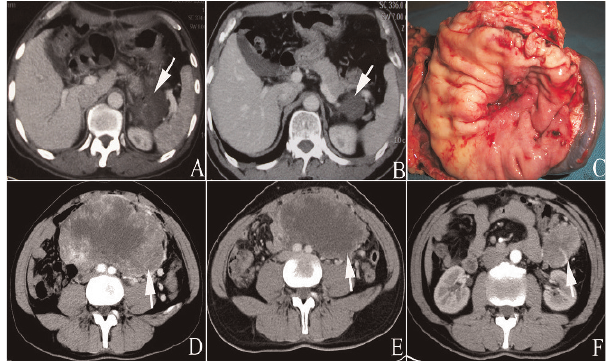
Figure 1 - (Patient no. 1, ABC) The abdominal enhanced CT scan (A) obtained at 3 months after initiation of IM therapy shows the tumor abutting the spleen (indicated by the arrow). However, after an additional 11 months of treatment, the CT findings (B) indicate tumor shrinkage and clearer tumor boundaries. (C) The operative photo shows that the patient underwent proximal gastrectomy with splenectomy. (Patient no. 3, DEF) This CT scan shows a huge tumor located in the abdominal cavity before medical treatment (D). The mass of this lesion was reduced significantly after 9 months of treatment (E). Unfortunately, this patient experienced tumor recurrence at 14 months postopera- tively and the CT scan (F) shows the location of the tumor in the upper left abdomen, spanning an area of 5.3 centimeters by 4.9